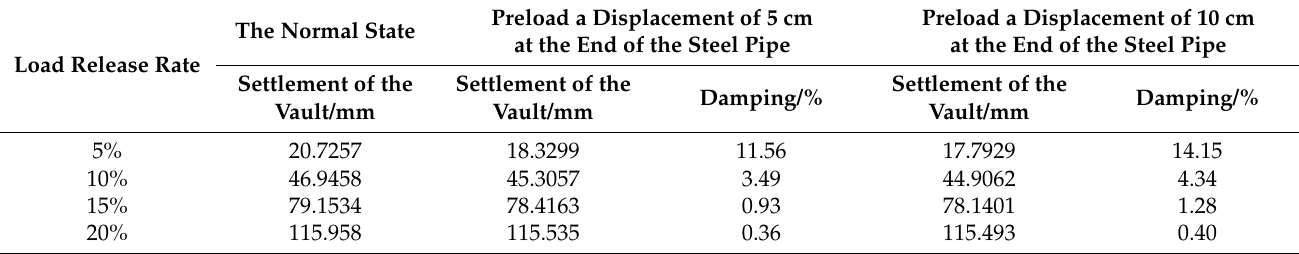
Figure 15. The installation of four and two active bearing FSPs. Table 2. The influence of four active bearing FSPs of 42 × 4 mm on settlement of the arch vault.